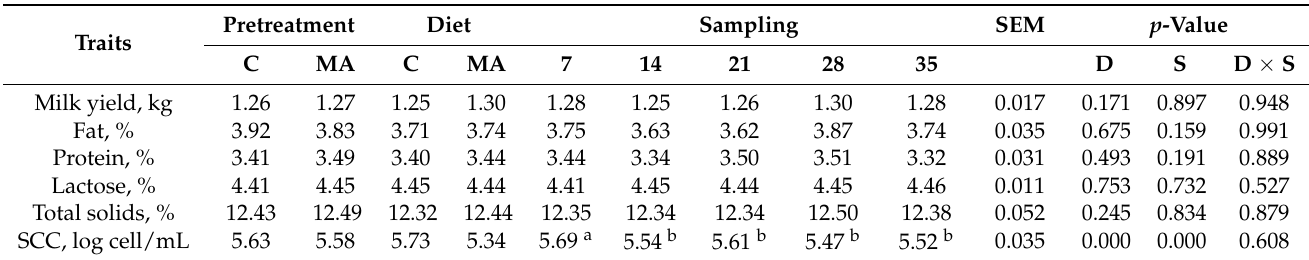
Table 2. Milk yield and chemical composition and somatic cell counts of goat milk from different feeding treatments all through the experimental period Pretreatment Traits